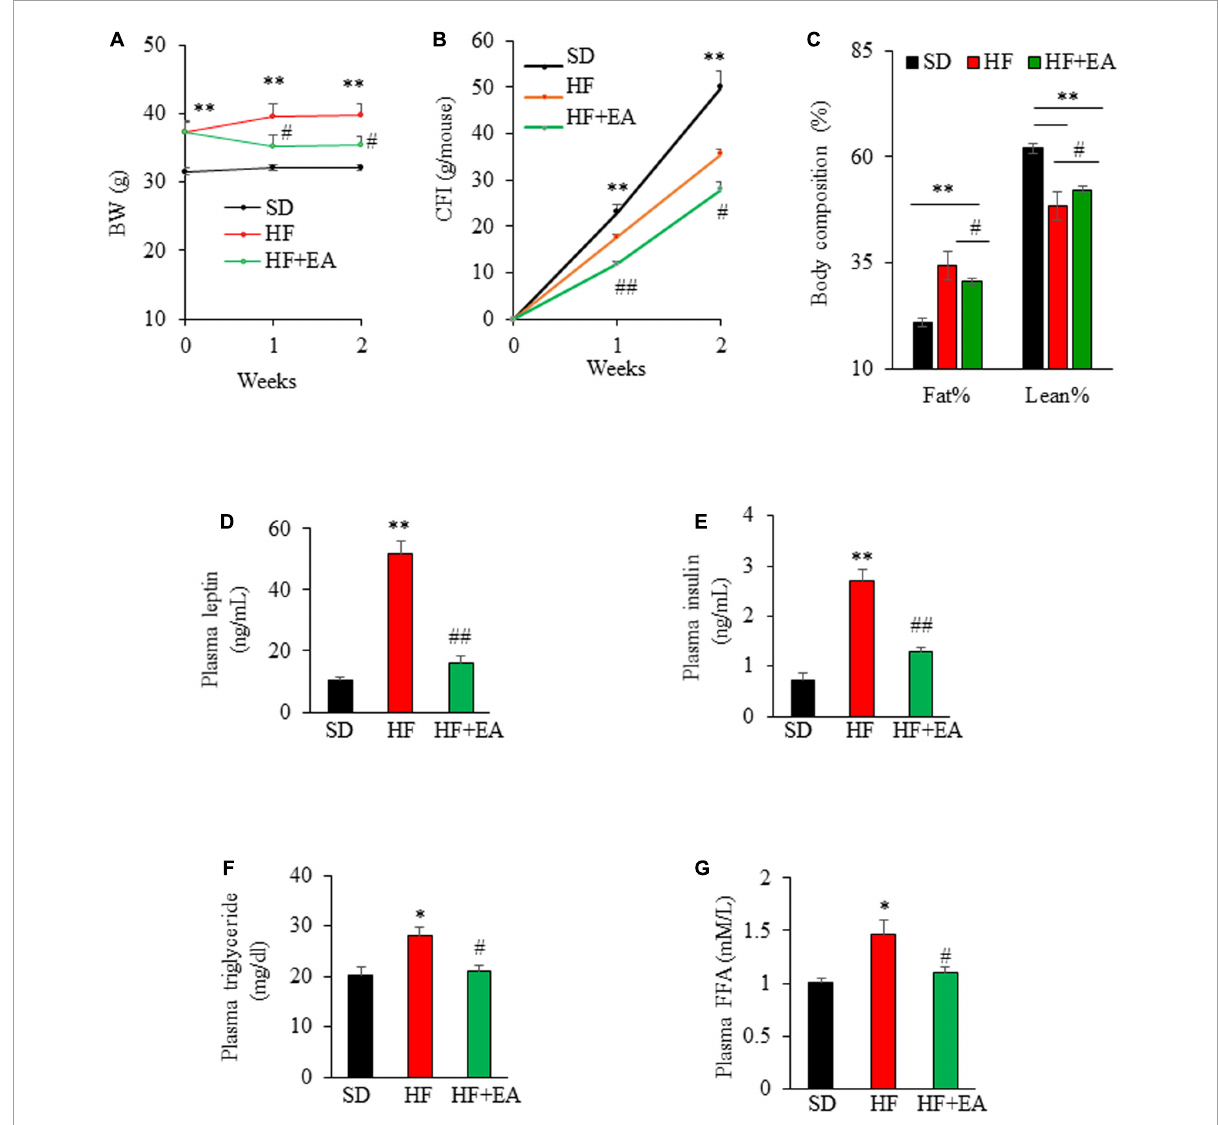
FIGURE5 Elenolic acid (EA) promotes weight loss and reverses obesity-associated biochemical alterations. Weekly body weight (A) and cumulative food intake (B) of obese mice on the vehicle or EA treatment for 2 weeks as described in Figure 5 . Body composition was measured at the end of the experiment (C) . Effects of EA treatment for 2 weeks on fasting plasma leptin (D) , insulin (E) , triglyceride (F) , and free fatty acid [ (G) , FFA] levels in obese mice as measured using ELISA kits. Data are Mean ± SE ( n = 8). ∗ p < 0.05, and ∗∗ P < 0.01 vs. SD-fed mice; # P < 0.05; and ## p < 0.01 vs. high-fat-diet (HF) alone-fed